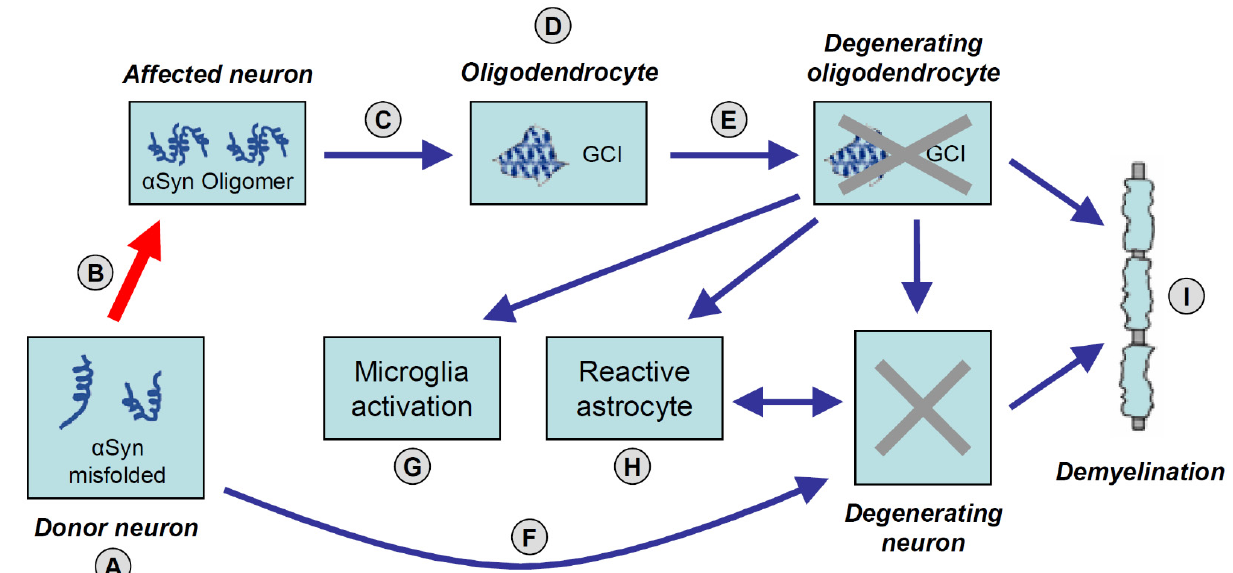
Figure 1. Suggested accumulation and spreading mechanisms of pathological α -synuclein ( α Syn) leading to neurodegen- eration in MSA. ( A ) Aggregation of α Syn as tetramers and oligomers in neurons. ( B ) “Prion-like” cell-to-cell spreading of abnormally folded α Syn via exosomes (red arrow). ( C ) α Syn aggregates and oligomers released from affected neurons into the extracellular space through exocytosis. ( D ) α Syn aggregation in oligodendroglial cytoplasm. ( E ) Formation of characteristic glial cytoplasmic inclusions (GCIs) in oligodendroglia containing α Syn and p25 α . ( F ) Prionoid material can be transmitted directly across synapses causing neurodegeneration. ( G ) Activated micro-/astroglial cells by cytokines released from damaged oligodendrocytes and degenerating neurons. ( H ) Aggregation of α Syn (or other prionoid material) in astrocytes that are also activated by neuronal loss. ( I ) Demyelination caused by damaged oligodendroglia and related to degenerating neurons.